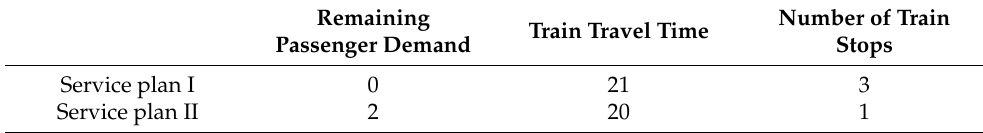
Table 4. Relevant indexes of